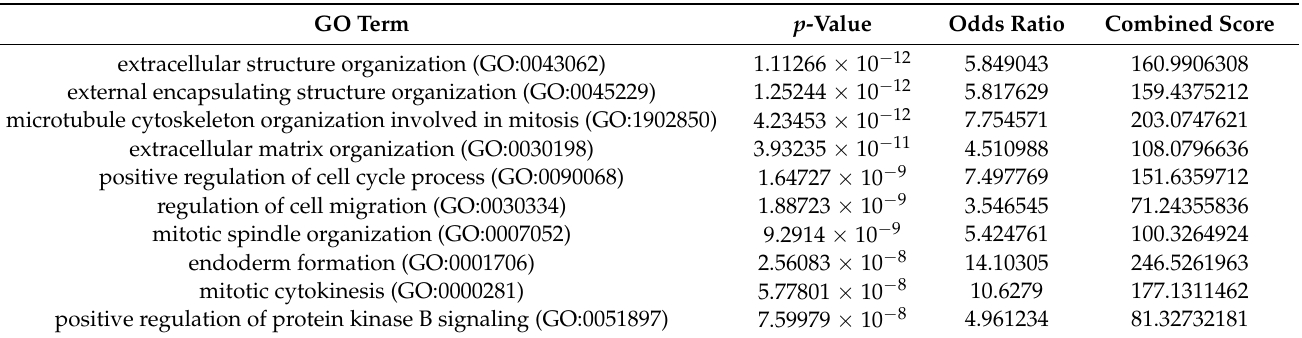
Table 2. The top 10 enriched GO terms in which the DEGs were significantly enriched, in the biological process